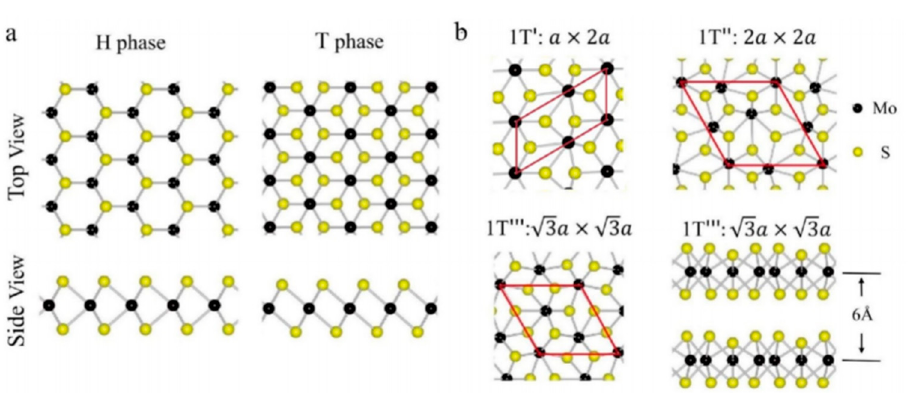
Figure 2. MoS 2 different crystal structures. ( a ) The top and side views of monolayer MoS 2 for H and T phases. ( b ) Different lattice structures of MoS 2 metallic phases 1T’, 1T’’, and 1T’’’. Adapted from [45]. American Physical Society 2018.